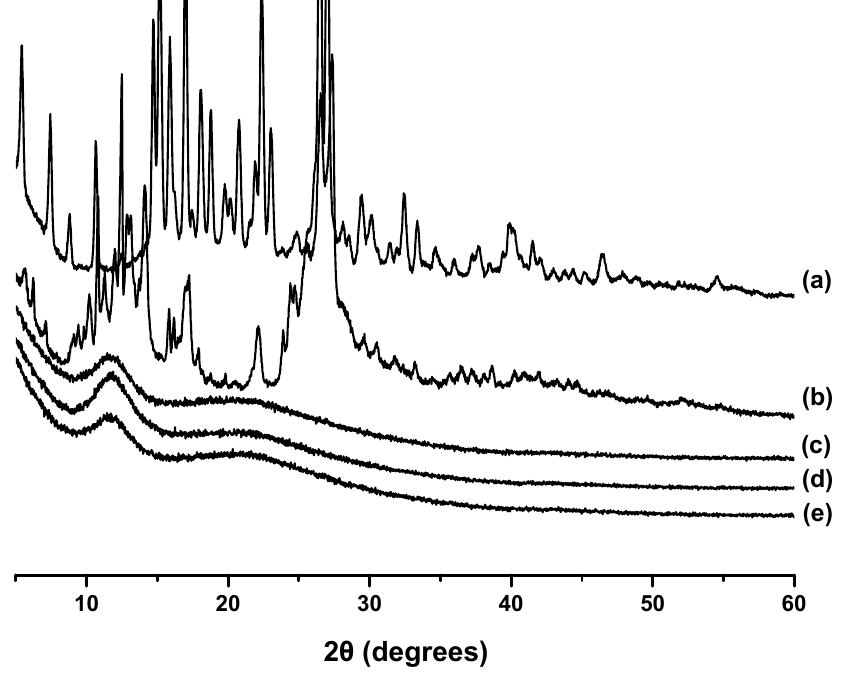
Figure 4. XRD patterns of: (a) rutin (powder), (b) quercetin (powder), (c) CA/PEG/RUT mat, (d) CA/PEG/QUE/RUT mat, and (e) CA/PEG/QUE+CA/PEG/RUT mat.